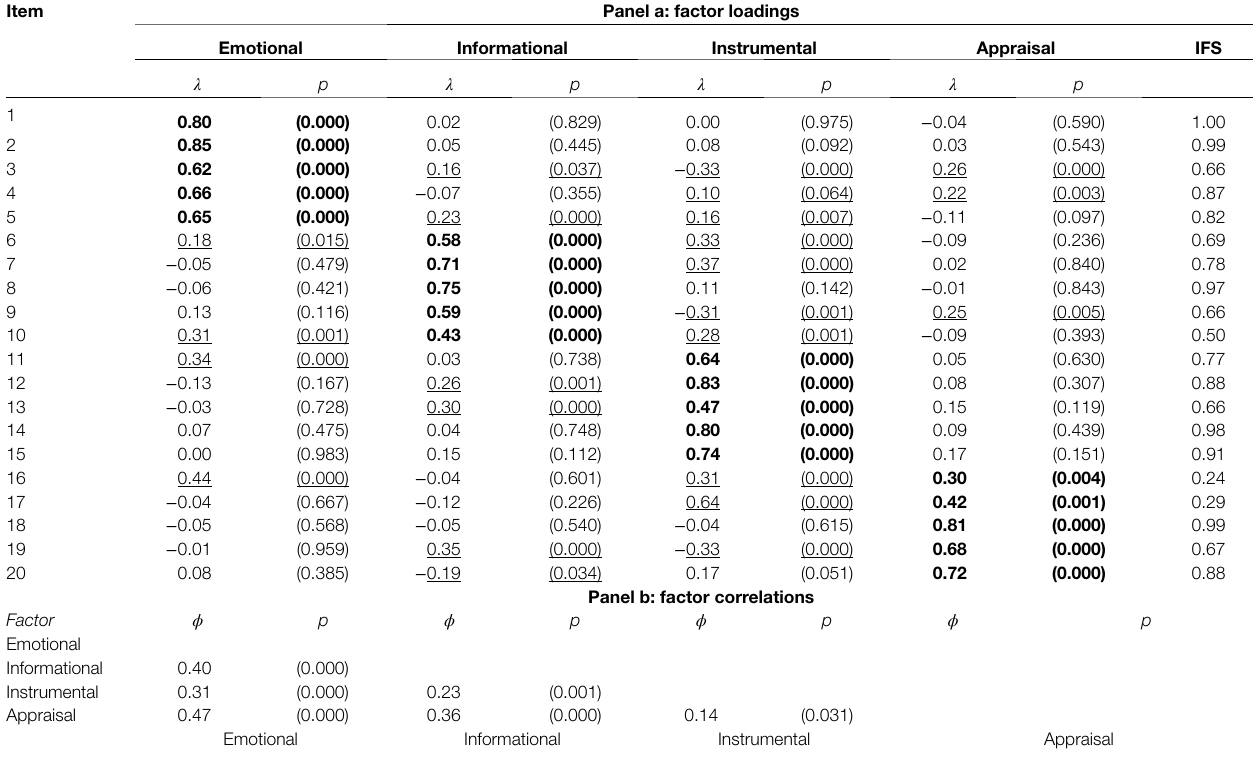
TABLE 3 | Standardized factor loadings and factor intercorrelations from the exploratory structural equation modeling four-factor solution of the HPSS. Item Panel a: factor